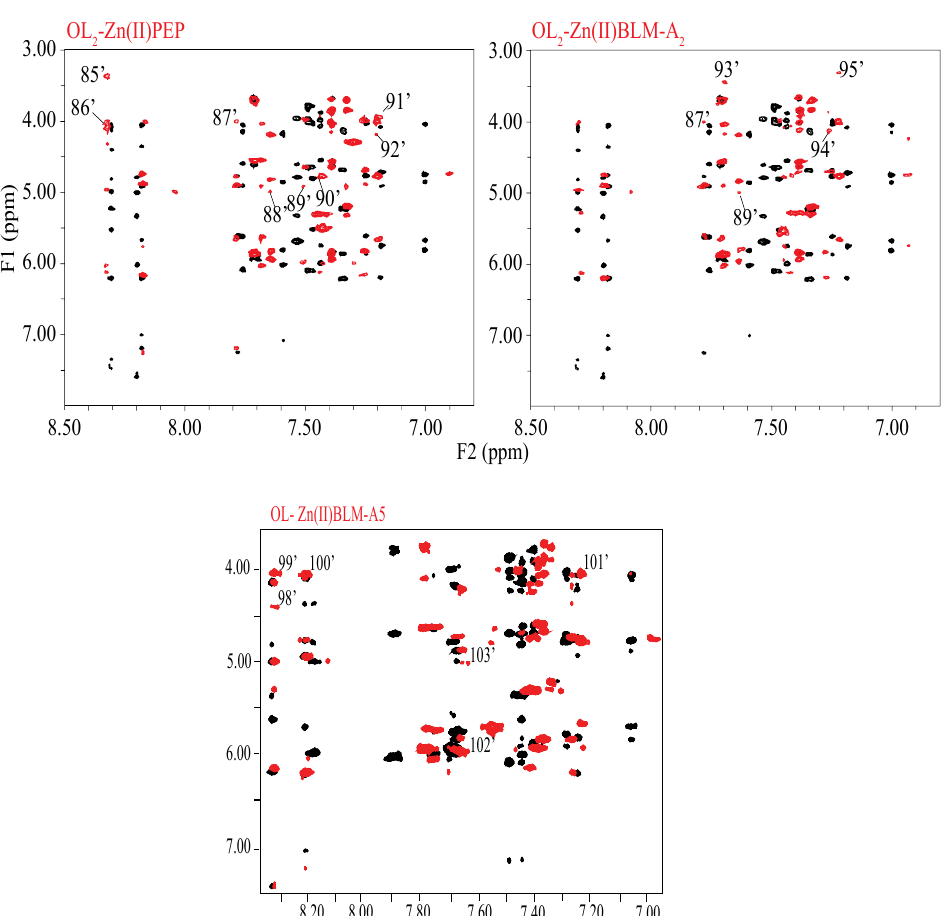
Figure 8. Schematic representation of the inter-base NOE connections for free OL 2 in D 2 O at 25 °C. Base–base (green) and base–sugar (blue). NOE connectivities are shown here with lines and listed in Table S2. Dashed lines are used to avoid confusion in the busy sectors of the scheme.